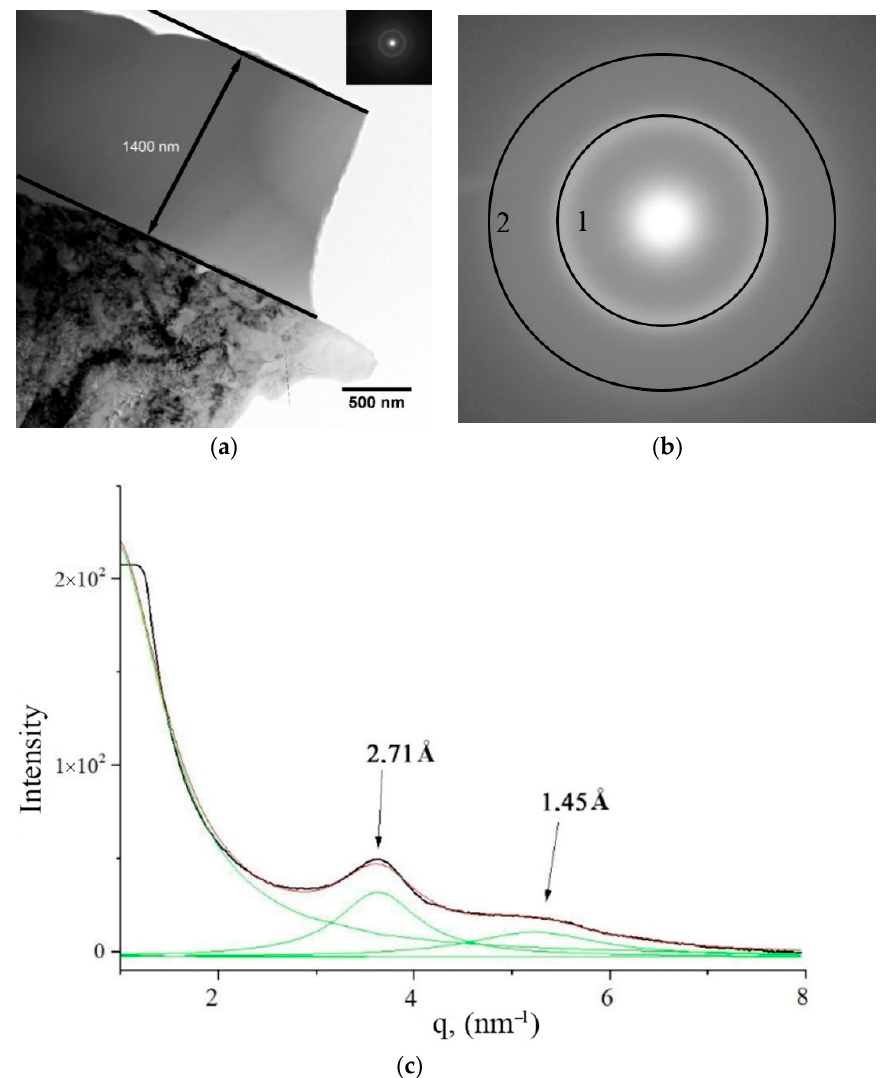
Figure 9. TEM image of the cross-section of the coating obtained by sputtering a Zn-HA target ( a ) with SAED ( b ) obtained from the coating area and the peaks of the two main diffusive halos, calculated from the SAED obtained from the amorphous layer ( c ).